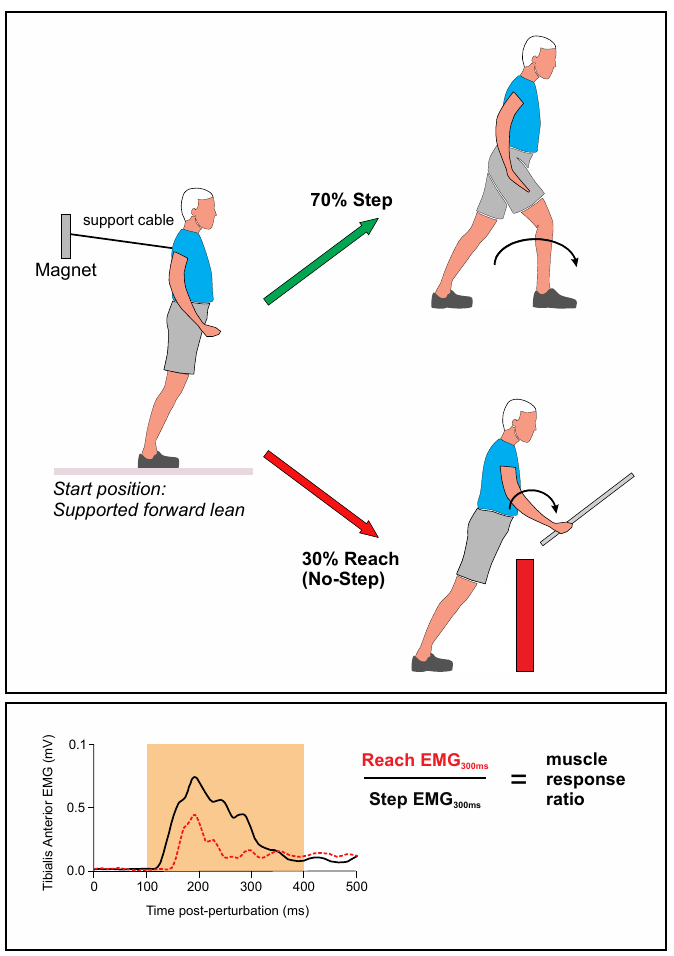
Figure 1. ( Top panel ): During the modified lean & release task, there are two options for recovering balance: take a step or grasp a railing (if the step is blocked). In total, 70% of trials were step trials and 30% were reach trials. In this illustration, the stance leg is the left, and step leg is the right. Below is a graphical representation of EMG activity from the tibialis anterior muscle immediately after cable release. The EMG activity is separately averaged for step trials versus reach trials (i.e., reach trials are those where a forward step is blocked and a support handle must be grasped to recover balance). ( Bottom panel ): Average rectified EMG is measured between 100 ms and 400 ms following cable release (EMG 300ms ) to calculate the muscle response ratio for each condition separately (step or reach). A low ratio means that a participant is good at suppressing a leg response during a forward step.